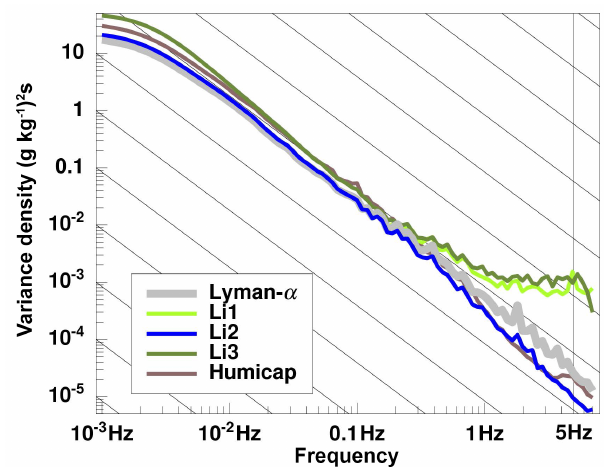
Figure 8. Power spectra (variance density) of the different humidity sensors on the Do128, Li1 in bright green, Li2 in blue, Li3 in olive, Lyman-alpha in grey and Humicap in purple. The spectra are aver- aged over the data of the time series shaded in grey in Fig. 3. The lines have a slope of − 5 / 3 according to Kolmogorov